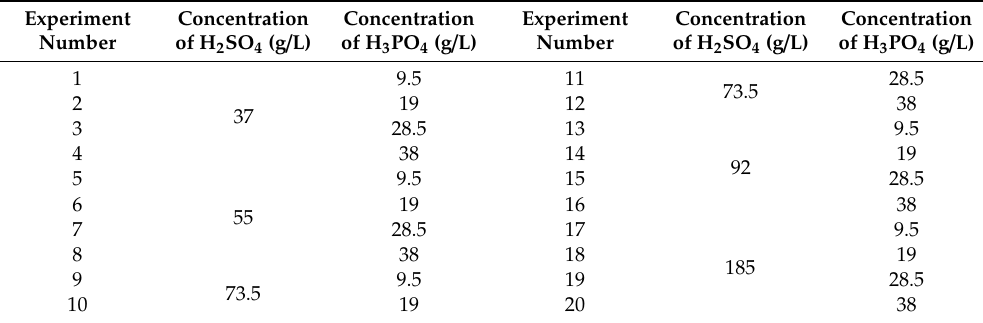
Table 4. Parameters of anodizing process.